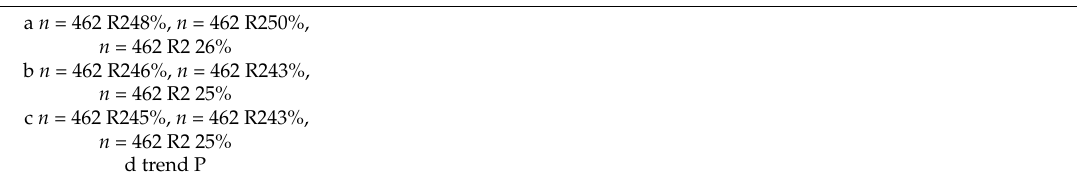
Table 4. Multivariable general linear models of an effect of covariates according to burnout subscale among faculties. Women vs.